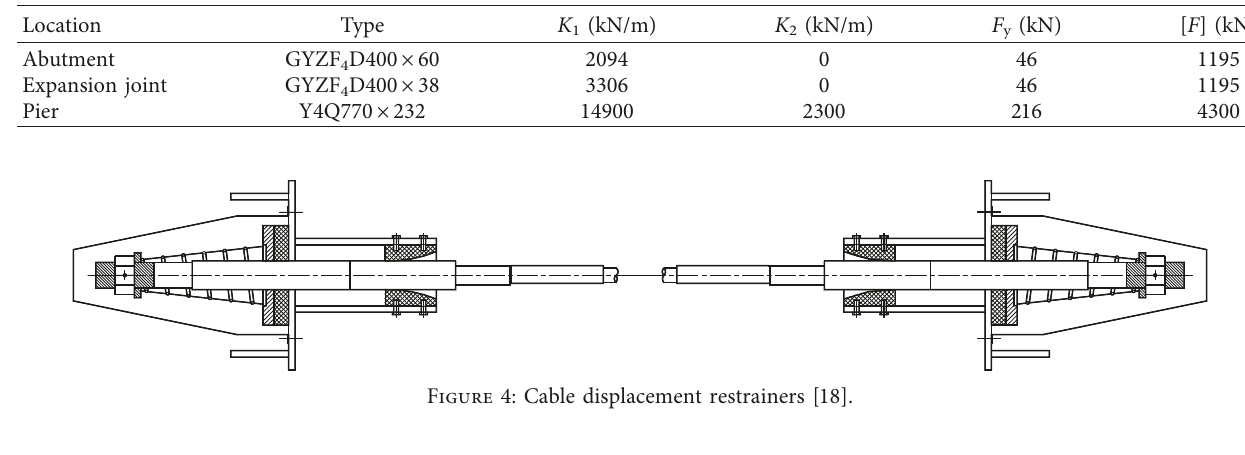
Table 2: Mechanical characteristics of bearings.